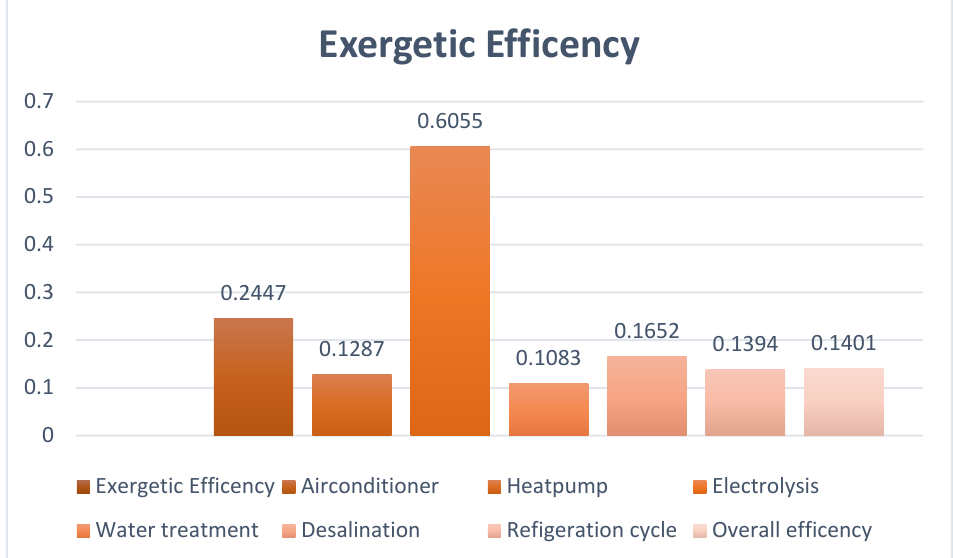
Figure 16. Exergy efficiency of different components.